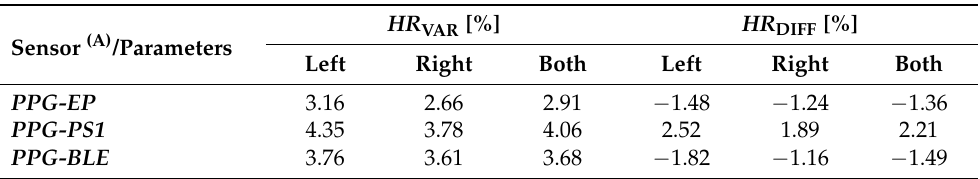
Figure 13. Statistical comparison of T NOS time intervals for tested PPG sensors: ( a ) boxplot of T NOS values for left hand forefingers, ( b ) boxplot for right hand forefingers, ( c ) mean T NOS values for both hands together; all tested persons.